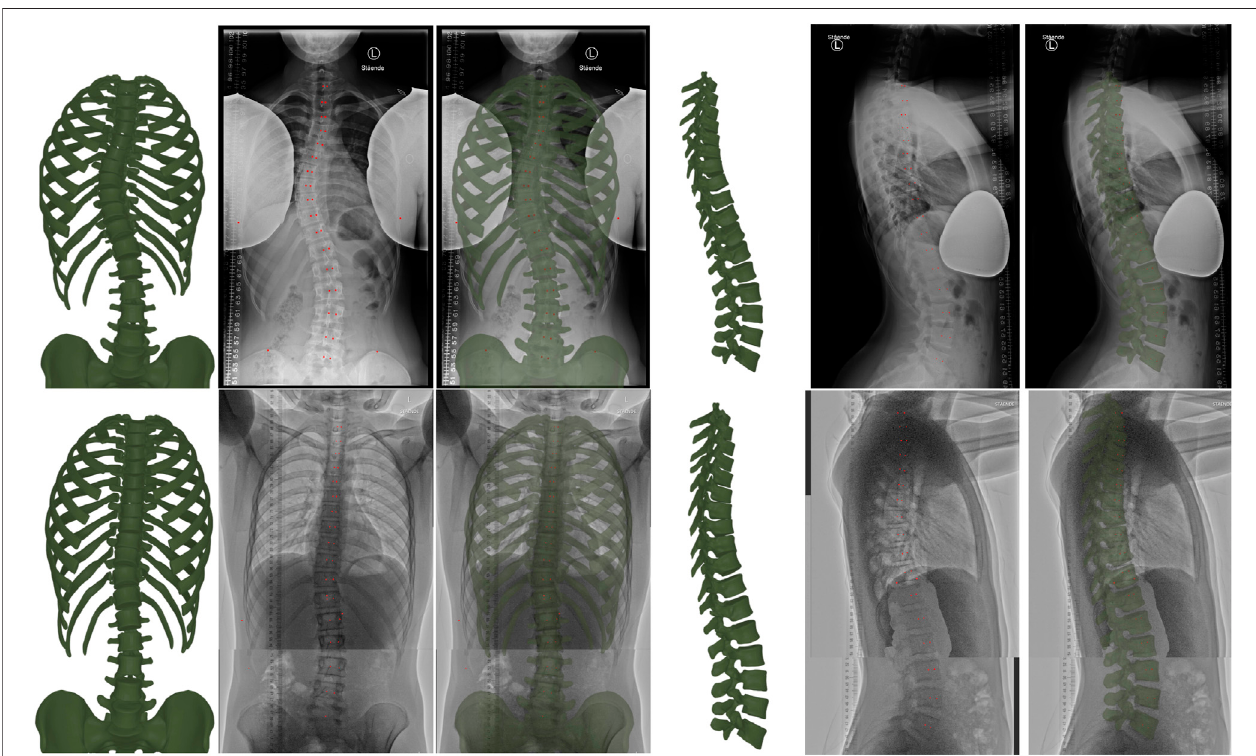
FIGURE3| Fromlefttoright,the fi gureillustratesthetorsoskeletonmodelresultingfromourmethod,theinputradiograph,andanoverlay(withtheresultingmodel drawn green semi-transparent), in both the frontal and sagittal planes. The top row corresponds to a case with normal-dose radiographs, and the bottom row to a case with low-dose radiographs. Note that we hide the sternum and cartilages in the frontal images, as well as the ribs in the sagittal images, to provide a clear view of the spine. The red dots are the points selected during manual annotation.